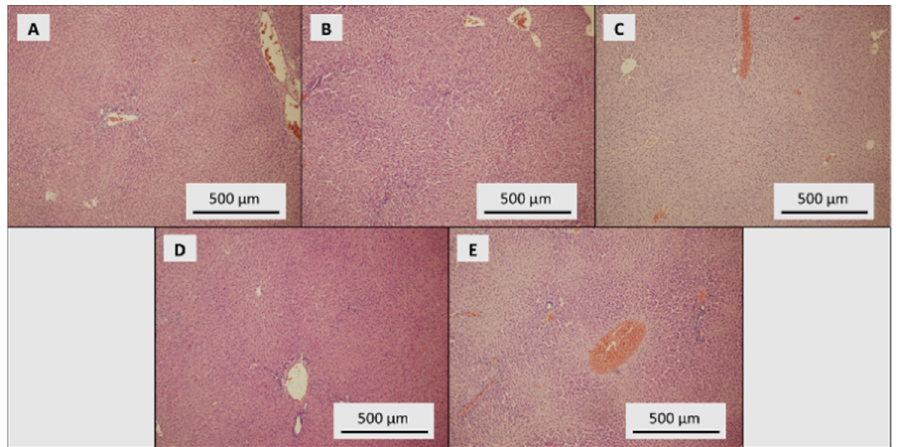
Figure 5. Histological examination of liver. ( A ) Control group, dose of SeNPs: ( B ) 0.5, ( C ) 1.5, ( D ) 3.0 and ( E ) 5 mg/kg/diet.